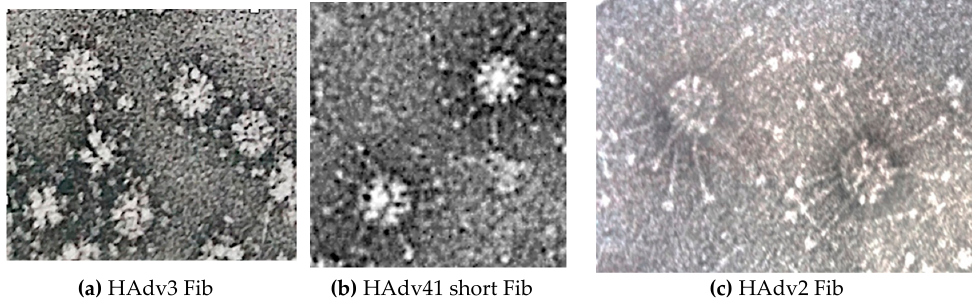
Figure 3. Recombinant HAdV3 dodecahedrons pseudotyped with different fibers. ( a ) Base Dodecahedron (Bs-Dd) coexpressed with its corresponding HAdV3 fibers, ( b ) the enteric HAdV41 short fiber, or ( c ) co-incubated with the HAdV2 fiber are observed by negative staining at the same scale (Bars: 30 nm).